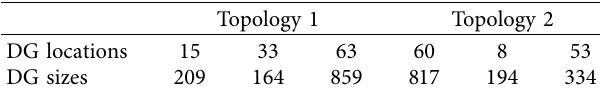
Table 4: Optimal locations and sizes of DGs for 69-bus.